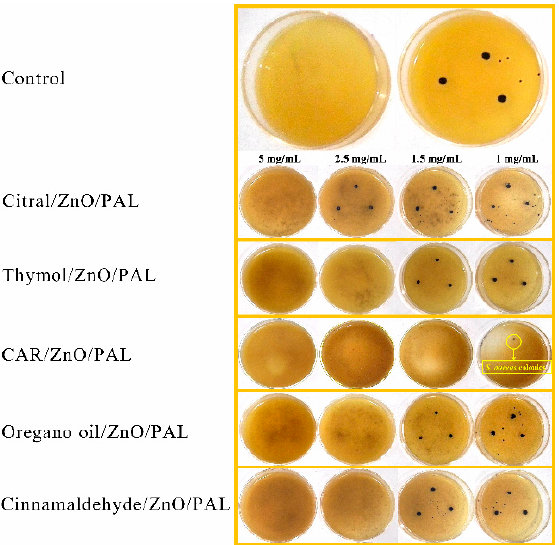
Figure 9. MIC value of PEOs/ZnO/PAL nanocomposites against S. aureus .